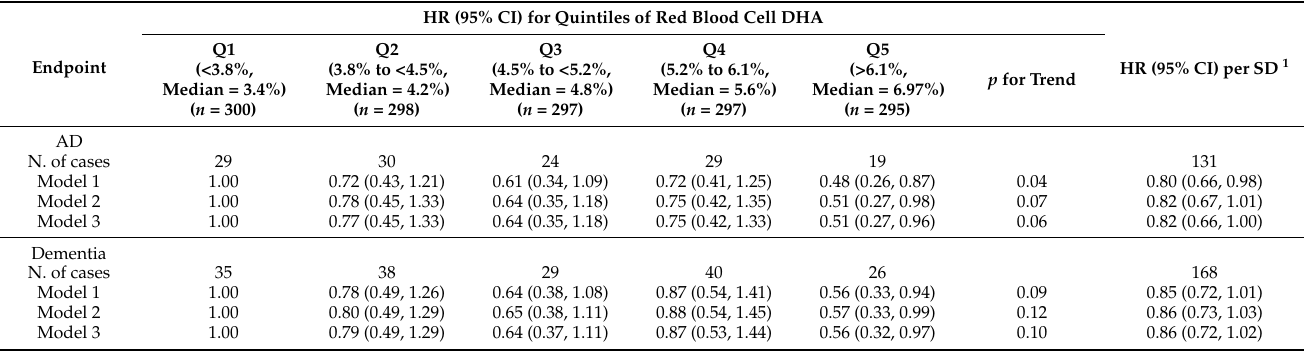
Table 2. Hazard ratios (HR) for red blood cell DHA on Alzheimer’s disease (AD) and all-cause dementia ( n =